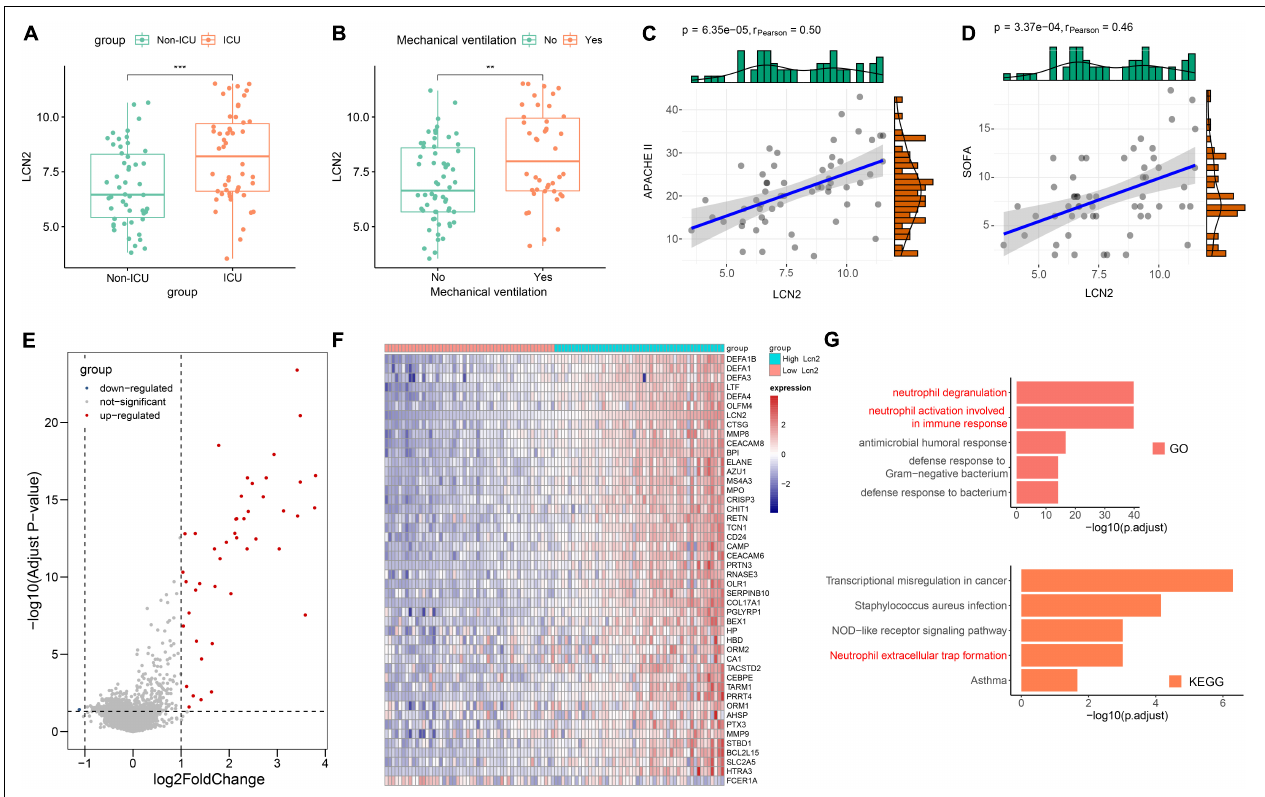
FIGURE 6 | The role of LCN2 in patients with COVID-19. (A) Expression level of LCN2 in ICU and non-ICU patients with COVID-19 (GSE157103). (B) Expression level of LCN2 in patients with COVID-19 with mechanical ventilation and without mechanical ventilation support. (C,D) Correlation analysis between LCN2 and SOFA, APACHE II in patients with COVID-19. (E) DEGs between patients with low LCN2 and high LCN2 with COVID-19. (F) Heatmap of DEGs between patients with low LCN2 and high LCN2 with COVID-19. (G) GO terms and KEGG pathway enrichment analysis of DEGs between patients with low LCN2 and high LCN2 with